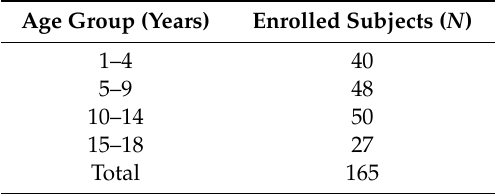
Table 1. Enrolled subjects divided into age